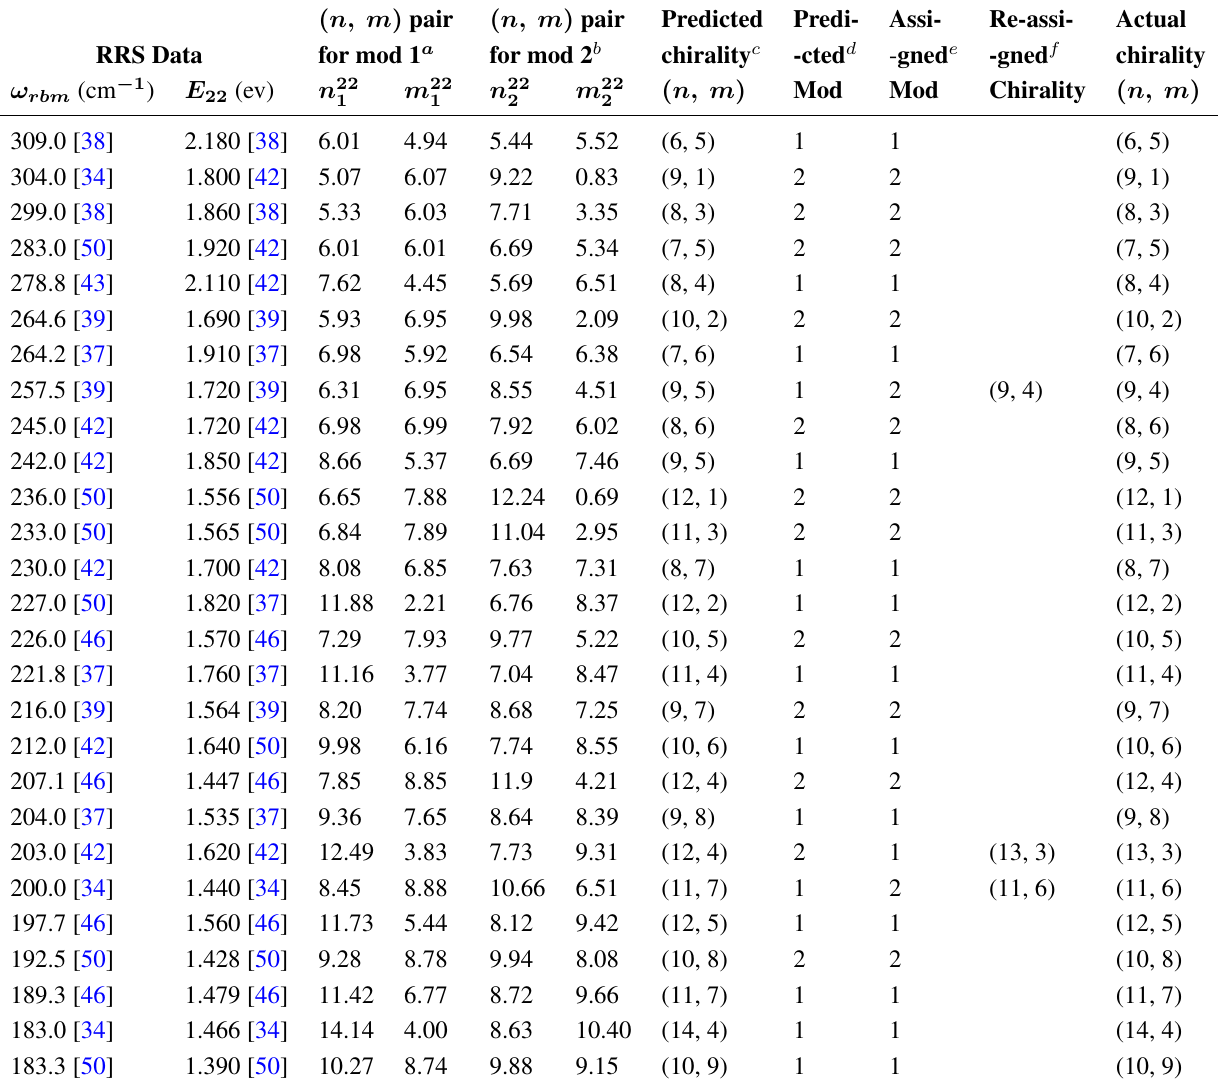
Table 4. Chirality Assignment of 27 semiconducting SWCNTs from E 24 of them are rightly assigned as the predicted and assigned mod type matched. The remaining three semiconducting SWCNTs are further treated using error detection and refining